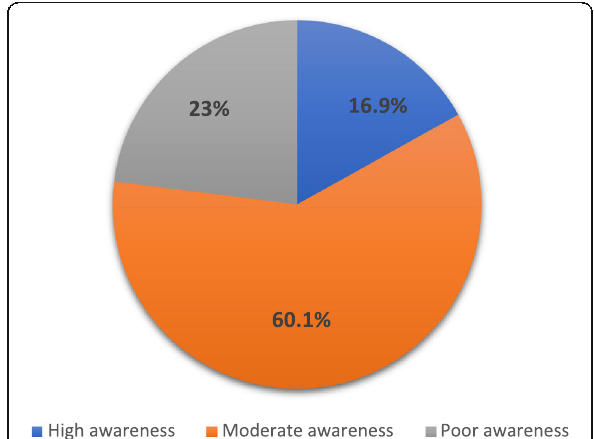
Fig. 2 Distribution of the college students according to the level of awareness ( n =